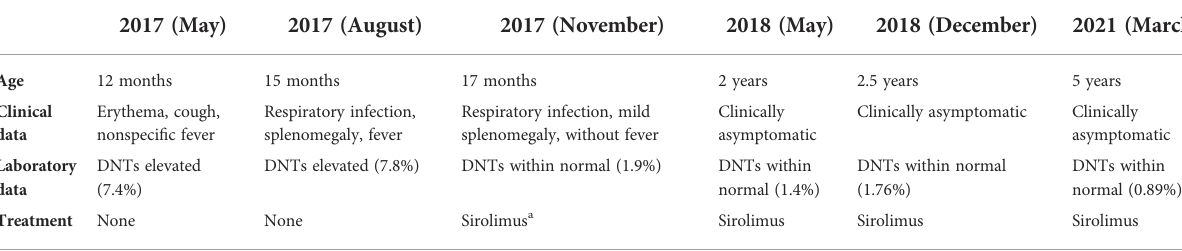
TABLE 1 Information on the clinical diagnosis, laboratory tests, and treatment of the index patient starting from the initial visit (May 2017) to the latest follow up (March